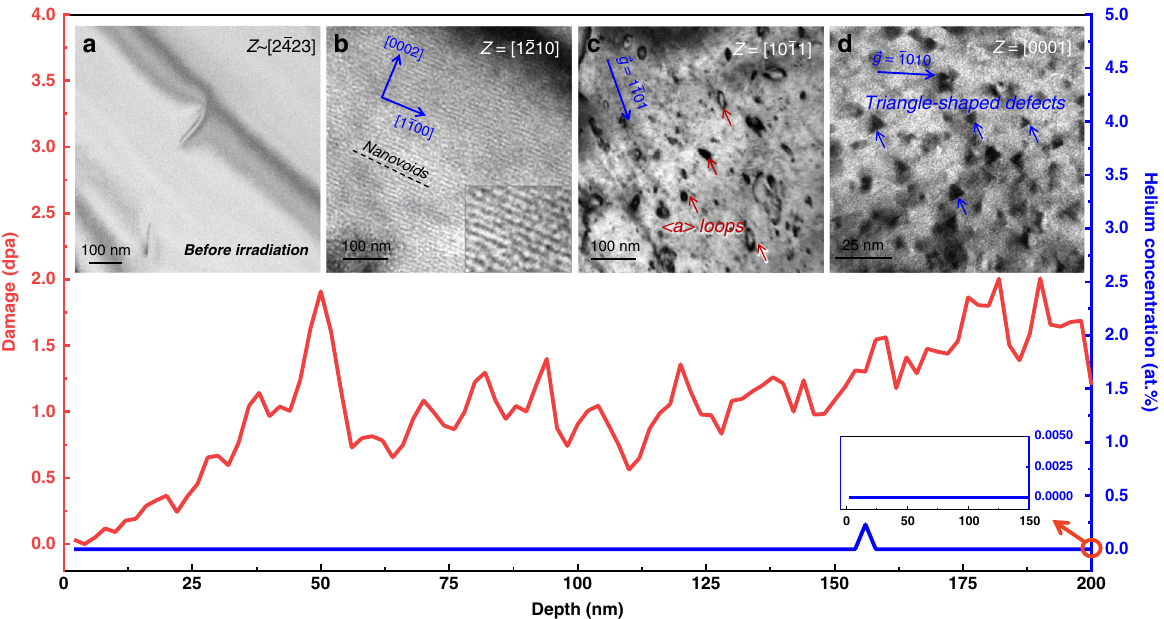
Fig. 1 The variation in radiation damage and helium concentration in the thin foil Zr. a TEM image of the as-received non-irradiated Zr. b Voids are produced along the basal plane at depths ranging from 0 to 50 nm. The insert in a shows an enlarged image of the ordered voids. c and d Dislocation loops and triangle-shaped defects produced at depths ranging from 50 to 200 nm. The insert shows that the helium concentration is Fig. 3c demonstrates an example of the coalescence of two dislocation loops observed at 400 °C. The number density of vacancy <a> loop increases at 400 °C. Figure 2d presents the fraction of interstitial and vacancy <a> loops formed at 400 °C. These results indicate more vacancy loops are produced at 400 °C than at 350 °C. We fi nd that most of the <a> dislocation loops are arranged randomly, as shown in Supplementary Figs. 2 and 3.